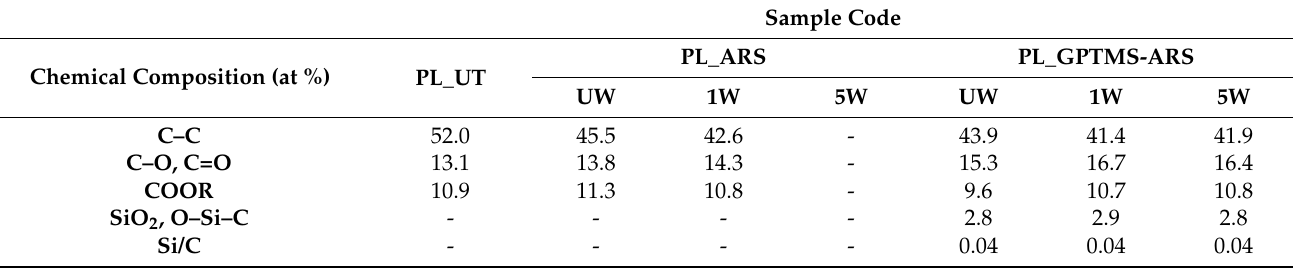
Table 2. Surface chemical composition (at %) of untreated polyester samples (PL_UT) and polyester samples treated with ARS (PL_ARS) and hybrid silane ARS (PL_GPTMS-ARS) before and after washing cycles (UW, 1W and 5W, respectively) with XPS analysis (10 % standard